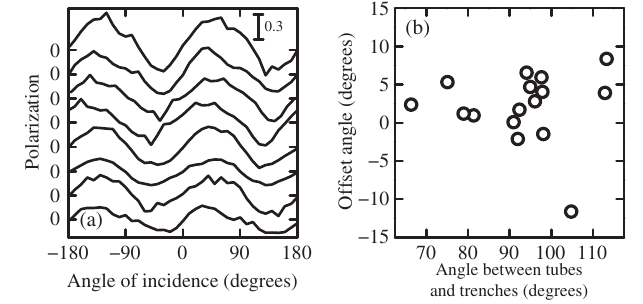
FIG. 4. (a) Angle-dependent polarization for eight representa- tive (9, 7) CNTs. The data are offset for clarity. (b) Offset angle plotted as a function of tube angle with respect to the trenches etched along the [110] direction of the Si substrate. Sixteen tubes with a chirality (9,7) are used to generate this plot. we plot θ 0 as a function of the angle between the nanotubes and the trenches, but we do not see a strong correlation.